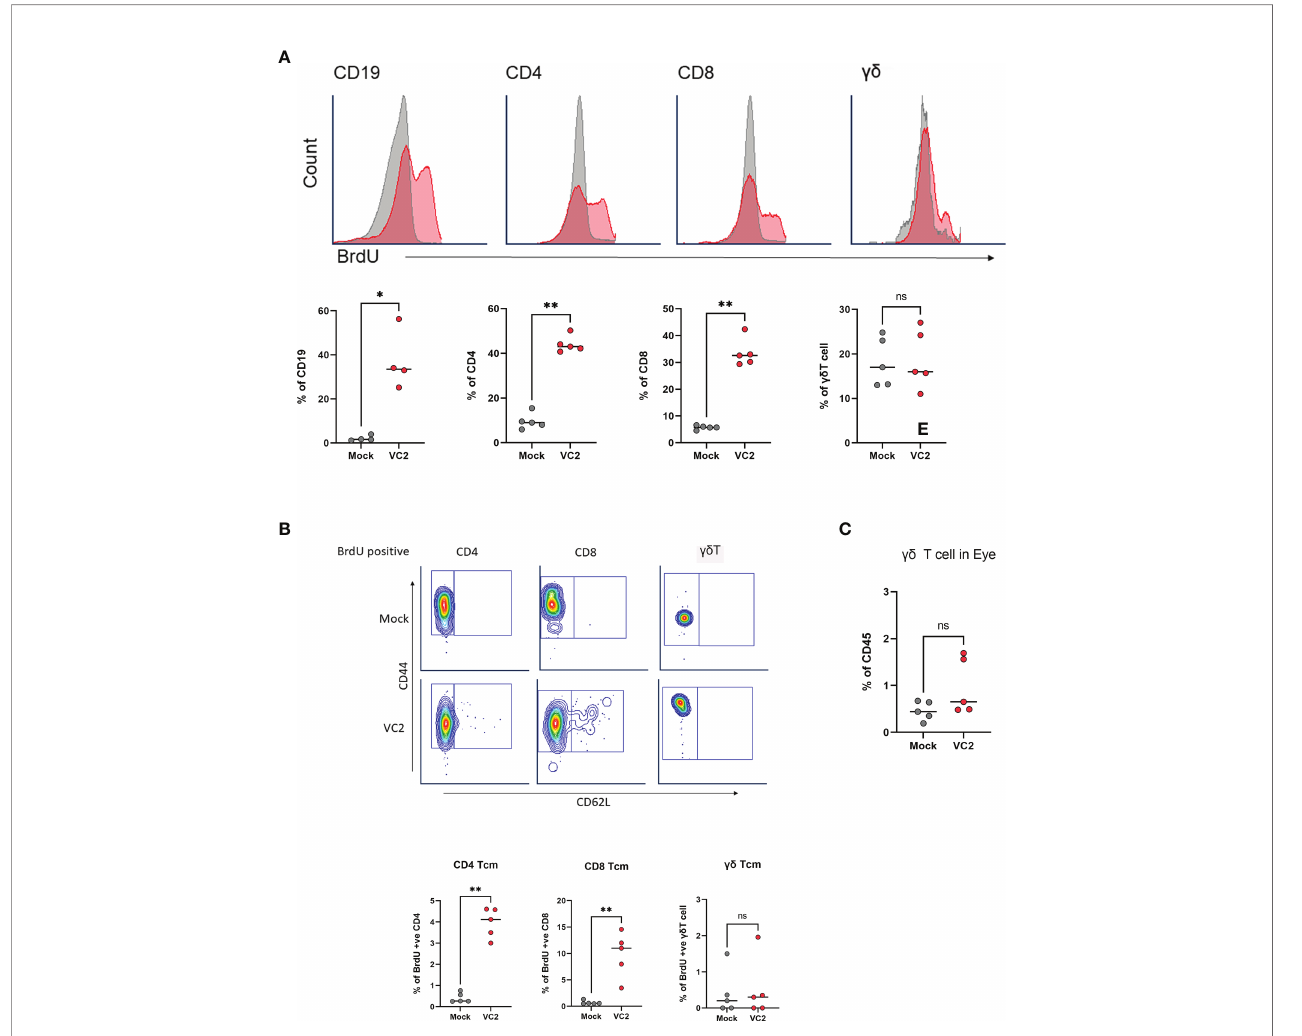
FIGURE 6 | Analysis of antigen-speci fi c memory T cell expansion in LN at 5DPI. (A) Representative histogram (top panel) and percentage of BrdU incorporation in CD19, CD4, CD8 and gd T cells in mLN cells using fl ow cytometry (bottom panel). (B) Representative gating (Top panel) and percentage of BrdU-positive TCM in CD4, CD8 and gd T cell populations. (C) Percentage of BrdU-positive gd T cell in the eye following infection. *<P=0.05, **<P=0.005 using Mann-Whitney test, n=5/group. ns, Non-Signi fi